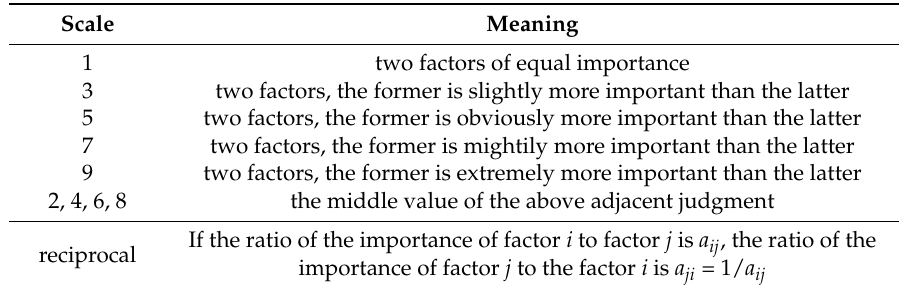
Table 8. The definition of the scale in the